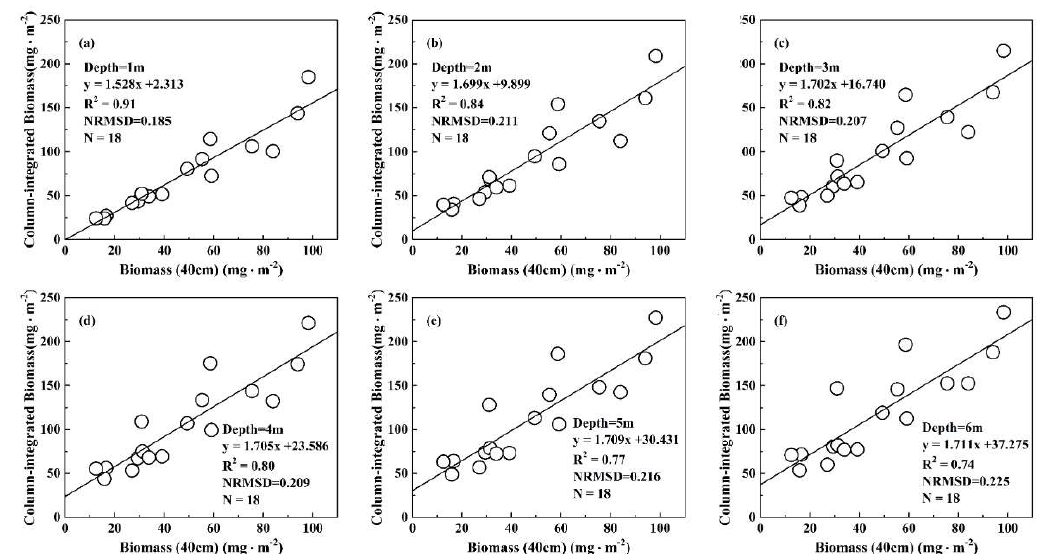
Figure 4. The relationship between algal biomass integrated from surface to 40 cm and total algal biomass integrated from surface to various depth based on in situ measurements. ( a – f ) represent depth from 1 to 6 m respectively (e.g., in ( e ), column-integrated algal biomass refers to algal biomass integrated from the surface to 6 m).